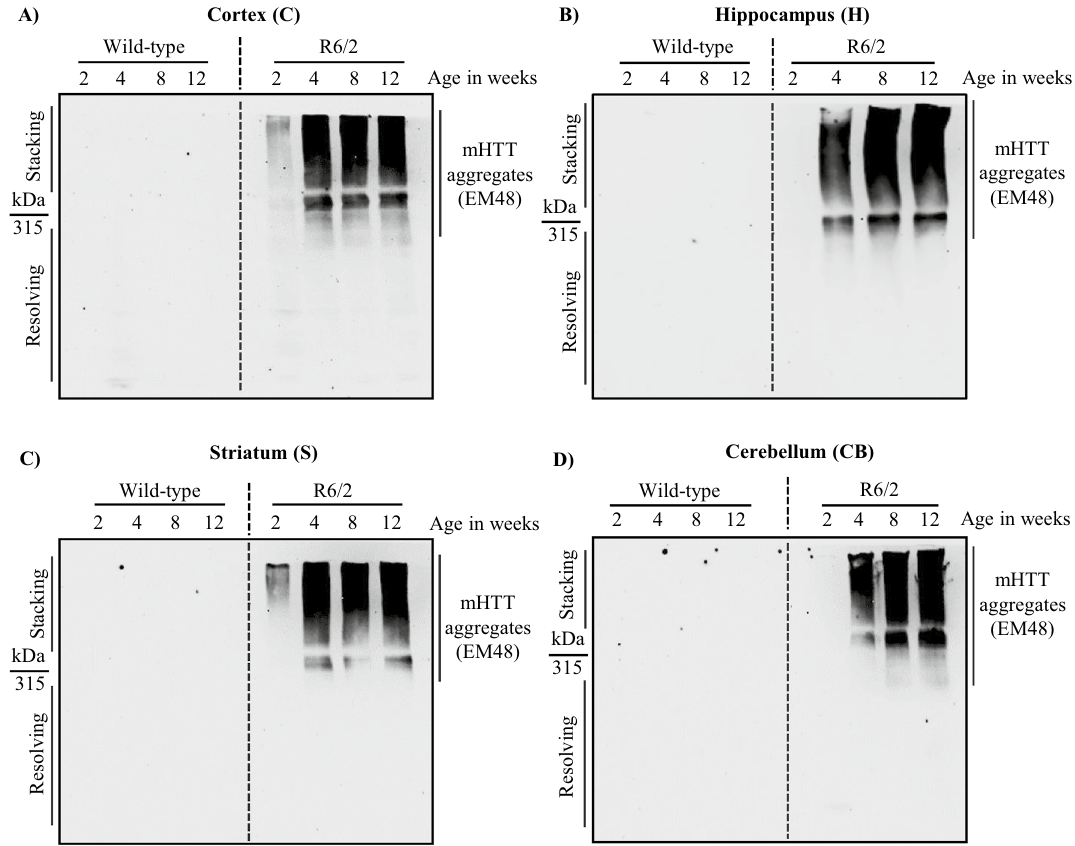
Figure 1. Dynamics of mHTT aggregate formation across different stages of disease progression in R6/2. ( A ) – ( D ) Representative blots for the expression of mHTT aggregates in R6/2 compared to wild-type control mice in the Cortex (C), Hippocampus (H), Striatum (S), and Cerebellum (CB) respectively at 2, 4, 8, and 12 weeks. mHTT aggregates were detected by EM48. N = 5 for 2 weeks, N = 7 for 4 and 8 weeks, and N = 12 for 12 weeks. N = number of mice. The genotypes are separated by vertical dashed lines. Image brightness and contrast were adjusted for representative purpose. Blots with different exposures and full uncropped raw blots are represented in the supplementary Figs. S1 and S7,